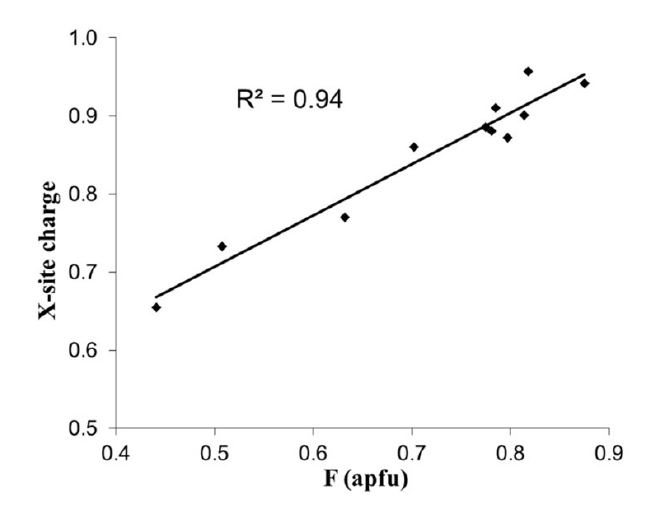
Figure 6. Correlation between the average X-site charge (Na 1 + , Ca 2 + , K 1 + , Bi 3 + ) in Cu-bearing tourmalines from the Alto dos Quintos mine, Rio Grande do Norte State, Brazil (samples from